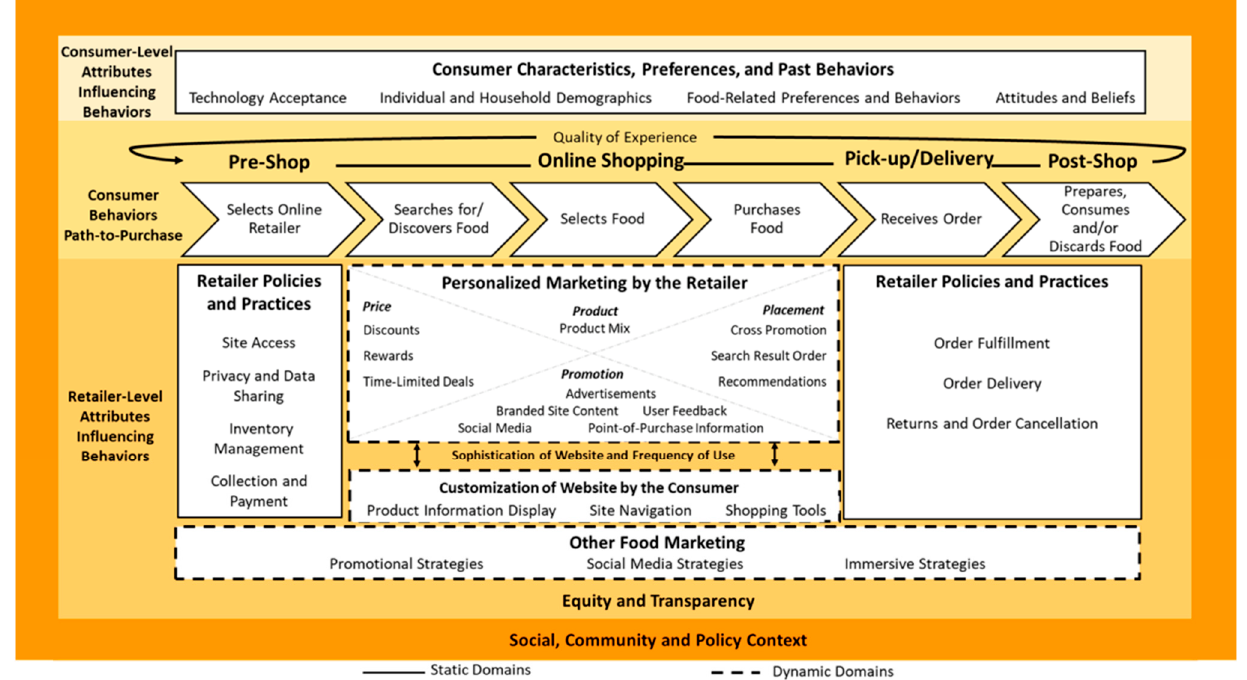
Figure 1. Khandpur et al. proposed online grocery framework. This framework outlines the different levels that comprise online grocery shopping and thereby can influence consumer engagement and utilization of online grocery services.